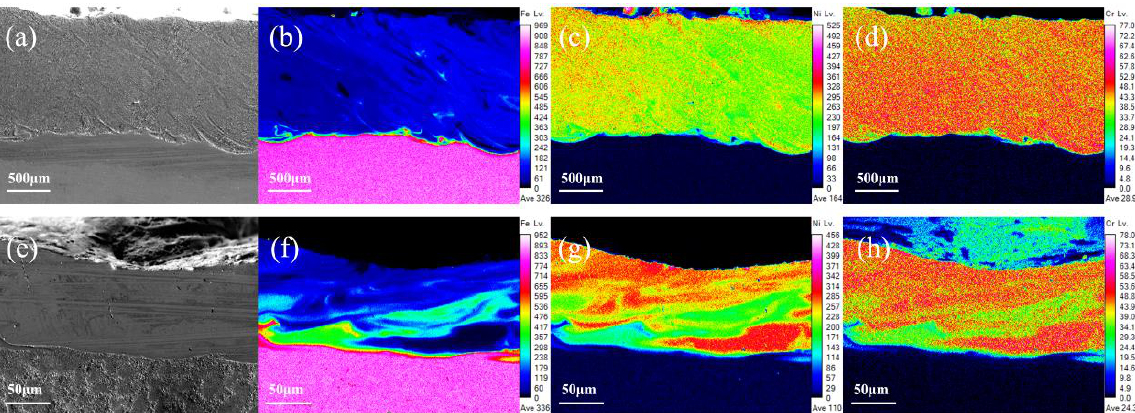
Figure 9. Main elements EPMA mapping image, LSLC Inconel625 alloys coatings: ( a ) SEM image; ( b ) Fe; ( c ) Ni; ( d ) Cr; UHSLC Inconel625 alloy coatings: ( e ) SEM image; ( f ) Fe; ( g ) Ni; ( h ) Cr.